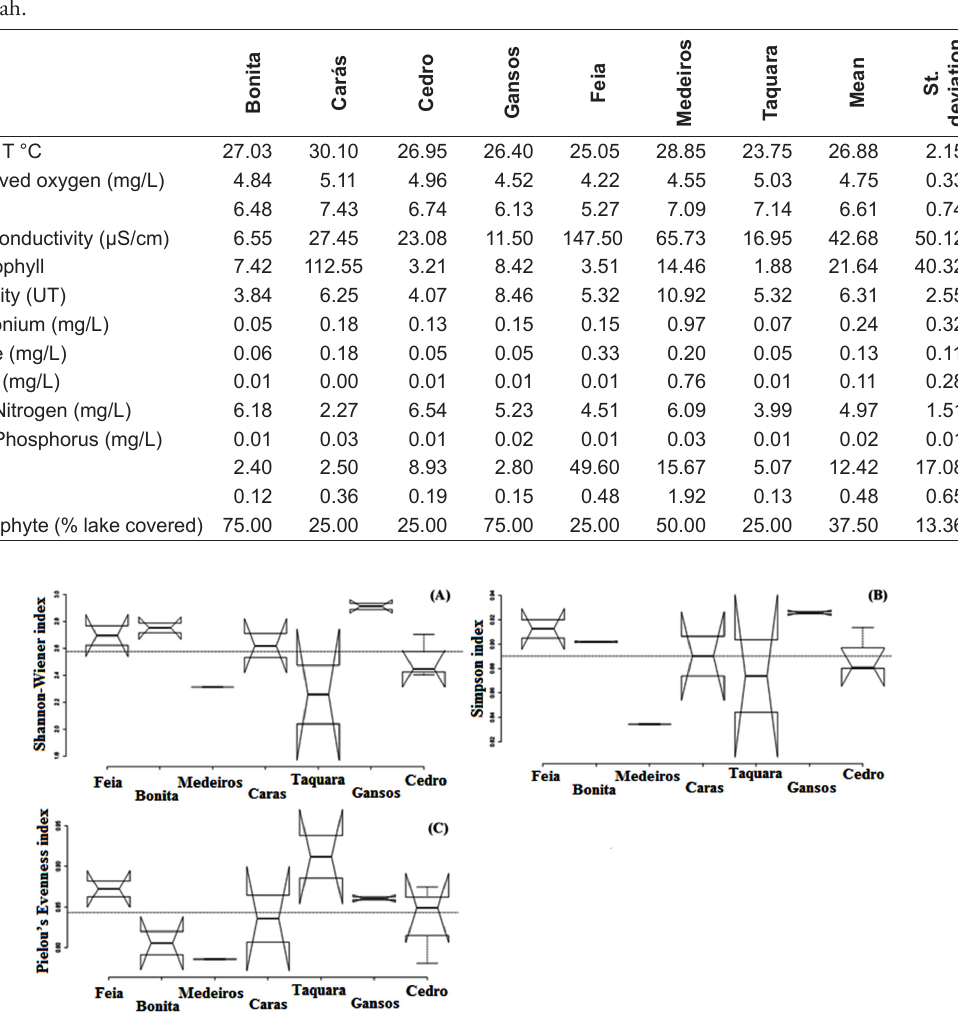
Figure 2. Average values (bold line), maximum and minimum (bars), third and first quartile (box), of the Shannon- Wiener index (A), Simpson index (B) and Pielou’s Evenness index (C) of all sampling points (shallow